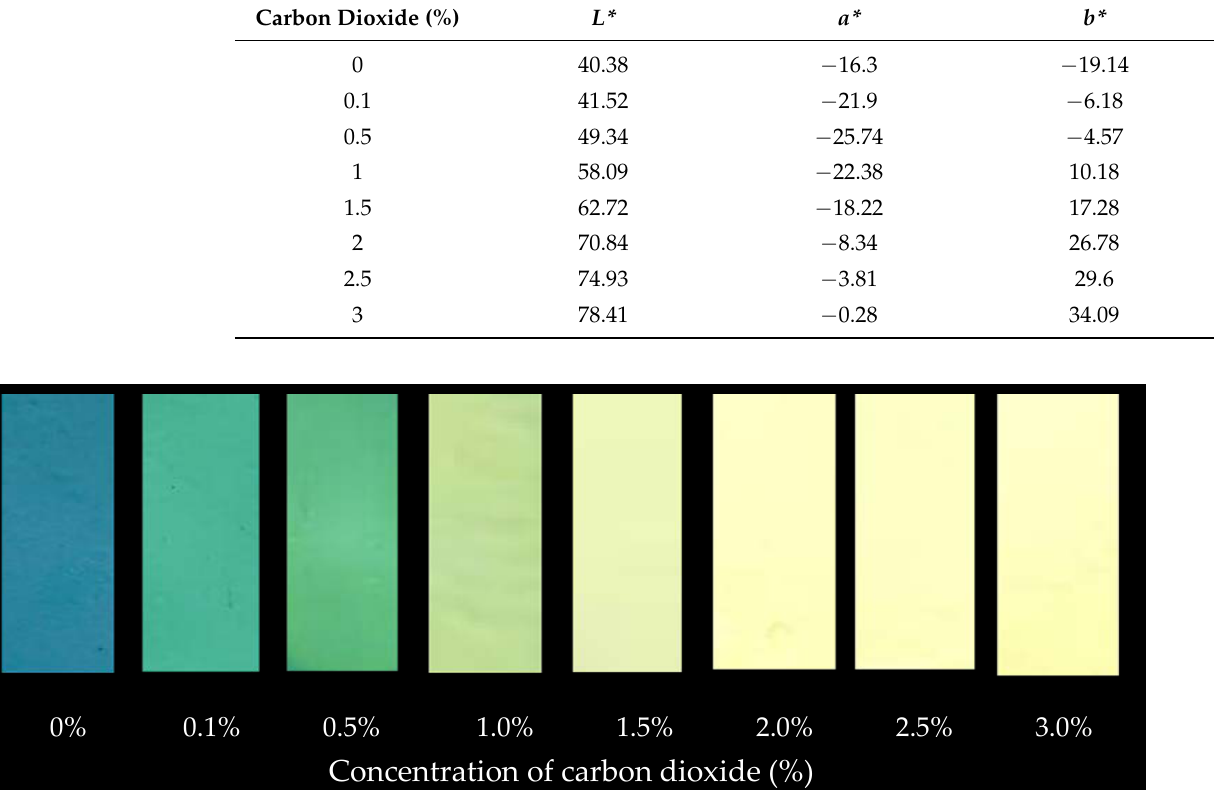
Figure 2. Change in color of indicator label in response to CO 2.